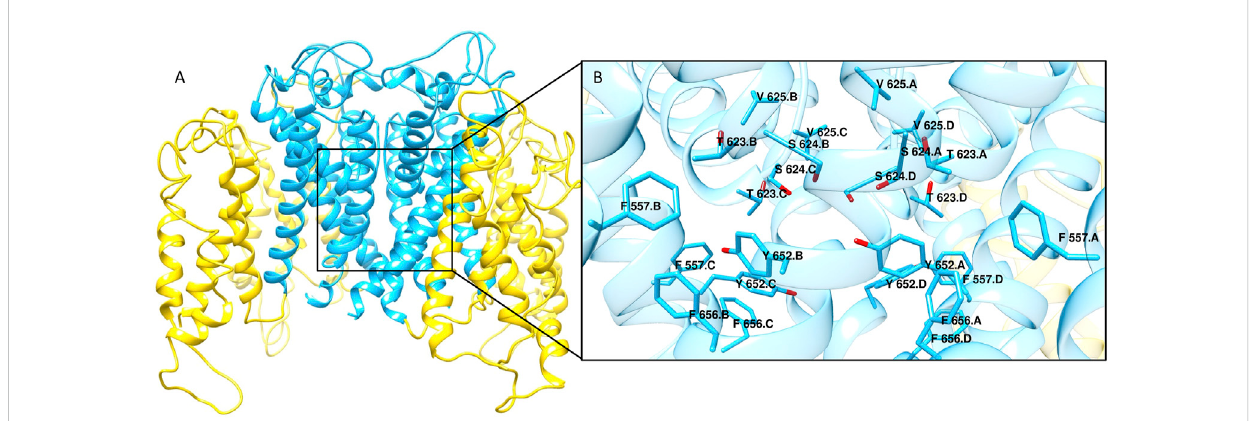
FIGURE 1 (A) Cryo-EMstructureofhERGchannelincomplexwithastemizole(PDBID7CN1).The α -helixesS1-S4constitutingthevoltagesensorareshownas yellowribbons,whilecyanribbonsrepresentthecoreregionofthechannel. (B) CloseviewofthemainligandbindingsiteforhERGblockers.Theresidues that are reported to be mainly involved in the interactions with hERG binders are displayed as cyan sticks.